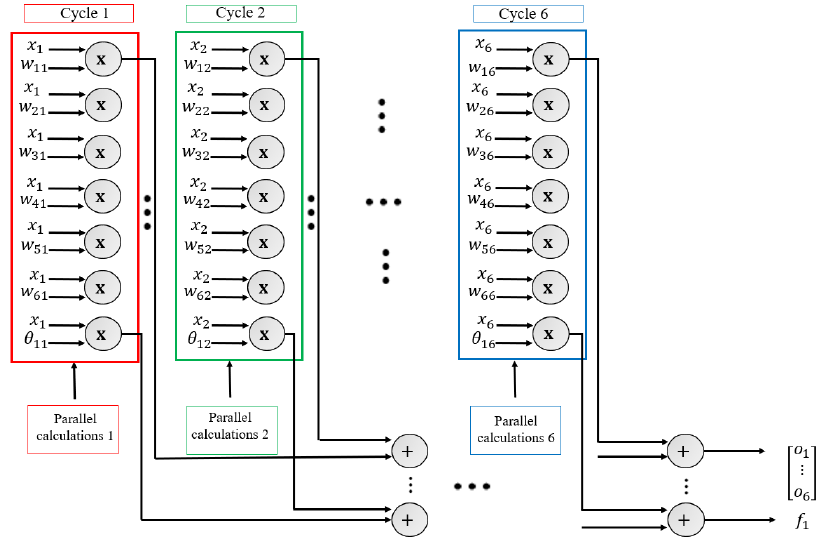
Figure 3. IP design for distributed memory.